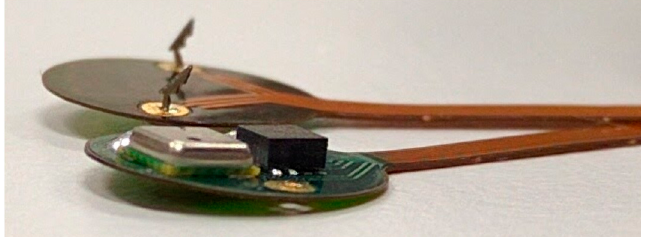
Figure 1. Bottom and top view of the device. The top contains a pressure sensor and a digital accelerometer. The bottom clearly illustrates the two protruding gold plated hook